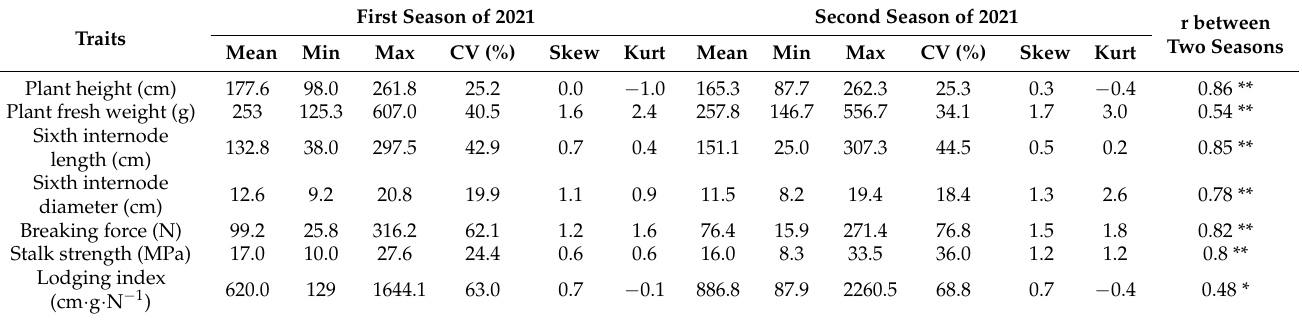
Table 2. Statistics of mechanical properties and relevant stalk traits of sorghum germplasm resources.